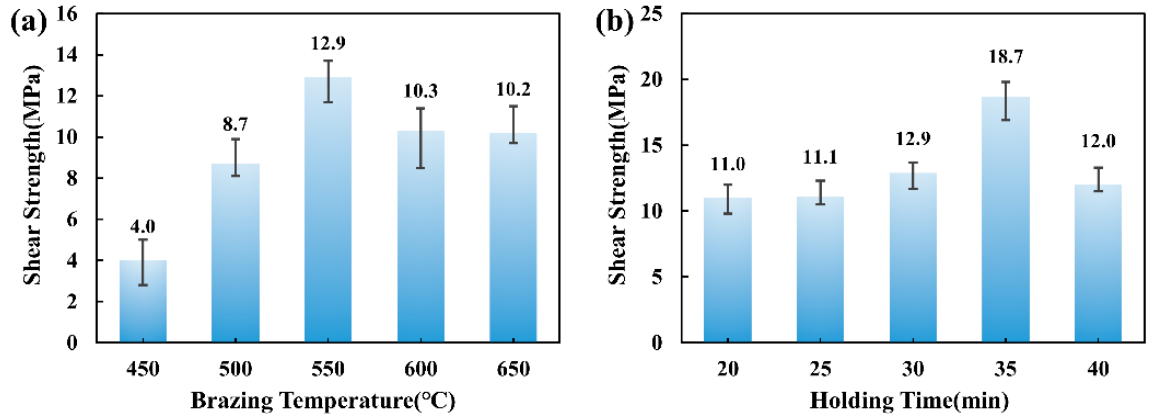
Figure 8. Shear strength of the titanium/AuSn20/Sn-3Ti/sapphire joints: ( a ) different brazing temperature and ( b ) different holding time.